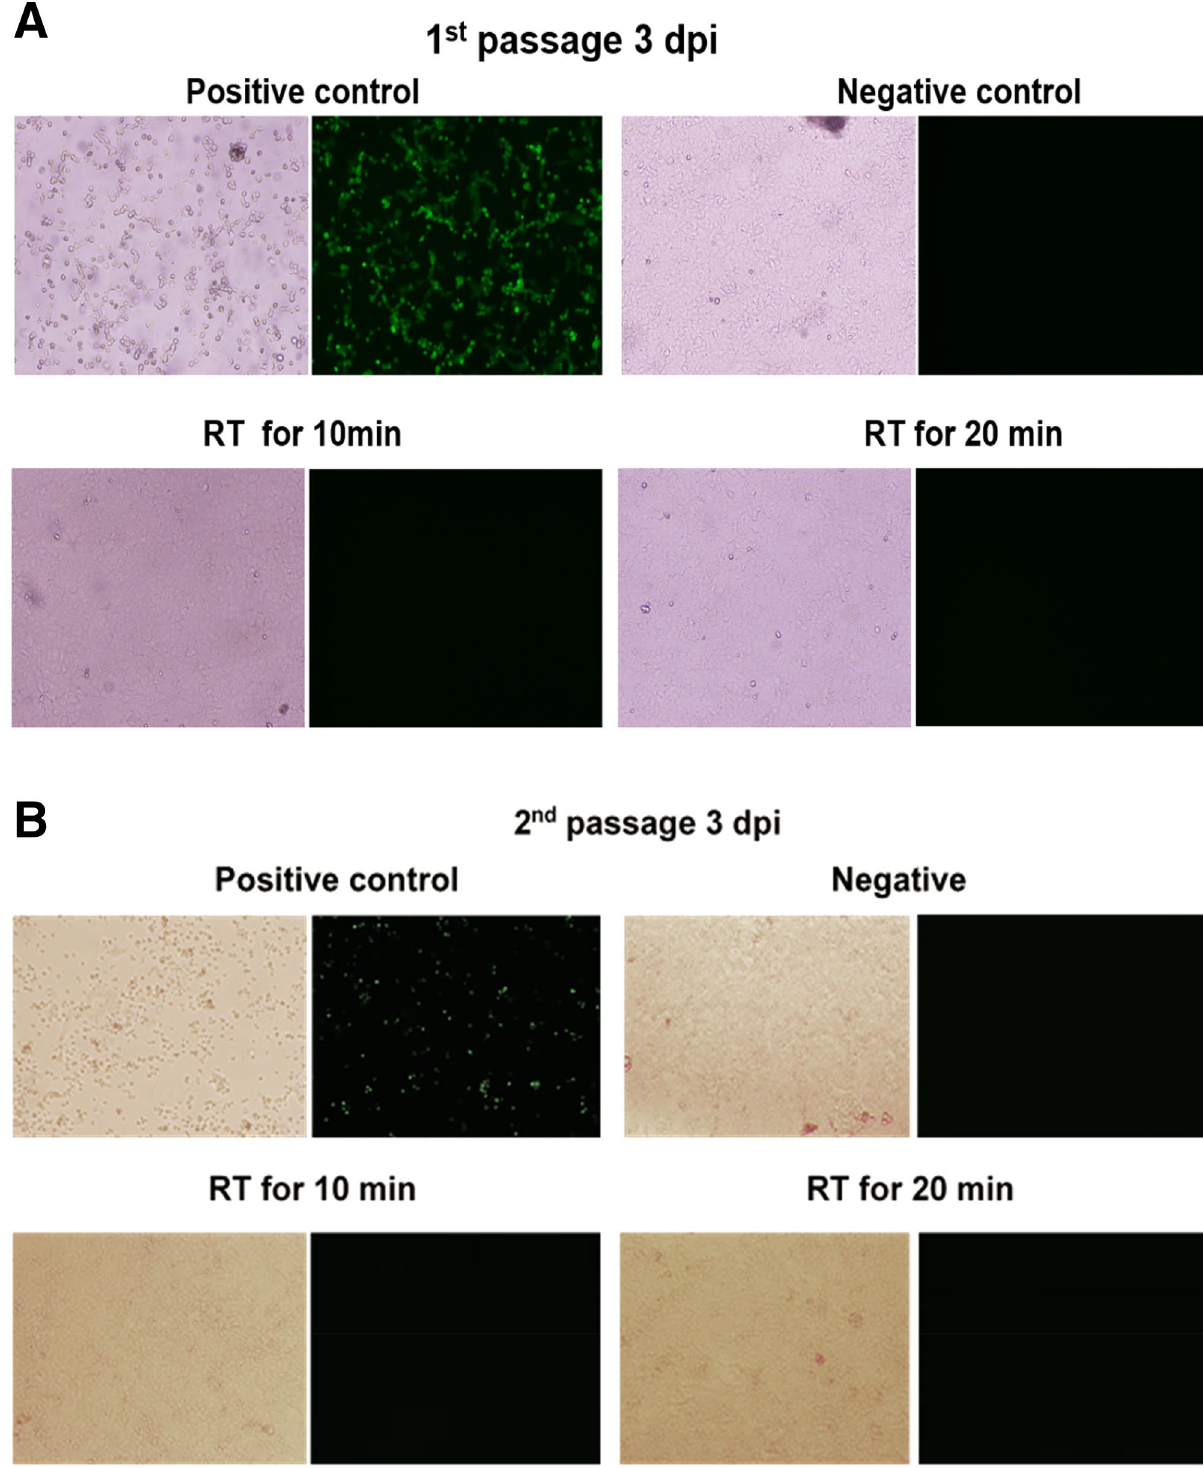
Figure 2. Immunofluorescence images of Vero E6 cells infected with mNG-SARS-CoV-2 diluted in vLAB. Immunofluorescence images of Vero E6 cells infected with stable mNeonGreen (mNG)-SARS-CoV-2 diluted or not in vLAB. Vero E6 Cells monolayers were analyzed 3 days post inoculation (3 dpi). Green cytoplasmic fluorescence is indicative of viral replication. ( A ) Pass1, stable mNeonGreen (mNG)-SARS-CoV-2 virus was diluted in vLAB and then incubated 10 and 20 min at room temperature (RT). Positive control, cells infected with mNG SARS-CoV-2 were diluted only with cell culture media; Negative control = only cell culture media. ( B ) Passage 2nd, supernatants from P1 (10 µL) were used to infect Vero E6